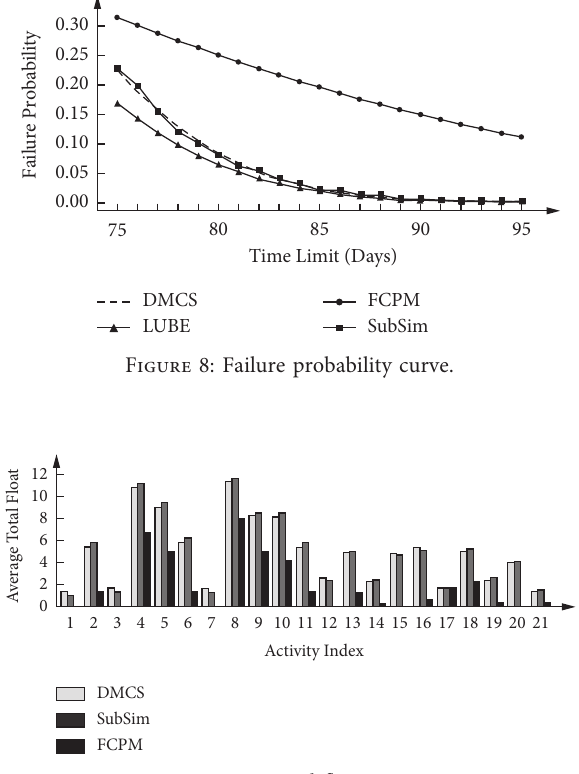
Figure 9: Average total float